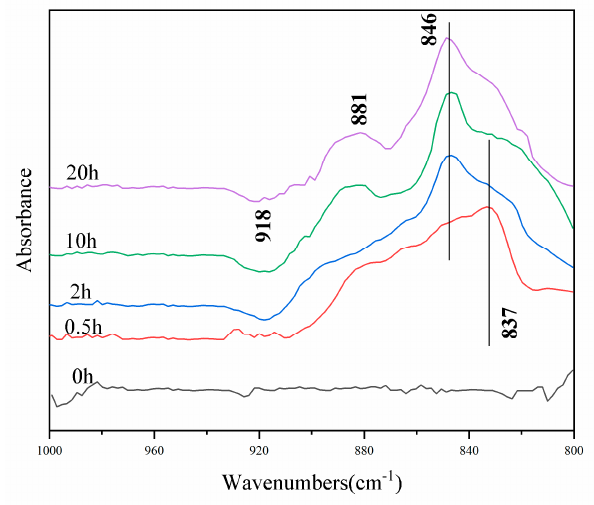
Figure 5. The real-time ATR-FTIR spectra of the in situ flow experiment of 100 µ mol L − 1 Se(IV) oxidation on δ -MnO 2 at a pH of 4 and 25 °C.